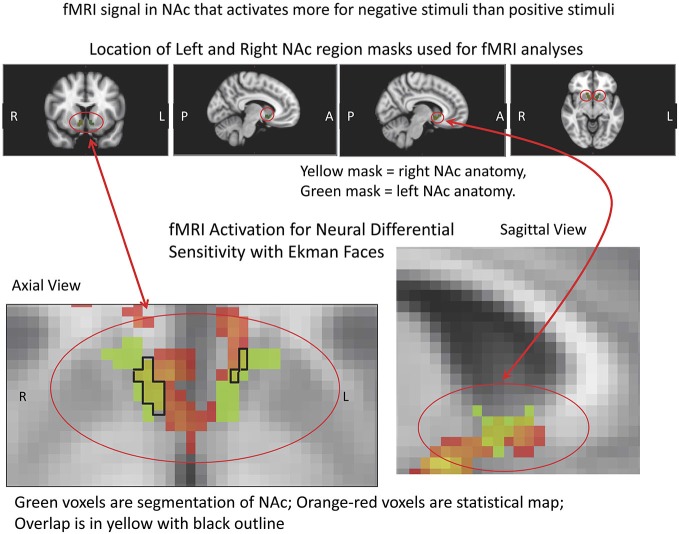
fMRI Masks and Activation for Neural Differential Sensitivity (NDS). The region of interest mask used for the VS/NAc is shown above in color with red circles, with the statistics for the subtraction of negative stimuli vs. positive stimuli in pseudocolor shown below. The segmented VS/NAc is shown in light green in the images below, superimposed on the gray-tone ICBM152 T1 template. The light green segmentations are overlaid with the orange-red statistical map for NDS. Overlap of segmented anatomy and statistical activation map is outlined in black, with yellow inside the closed line.